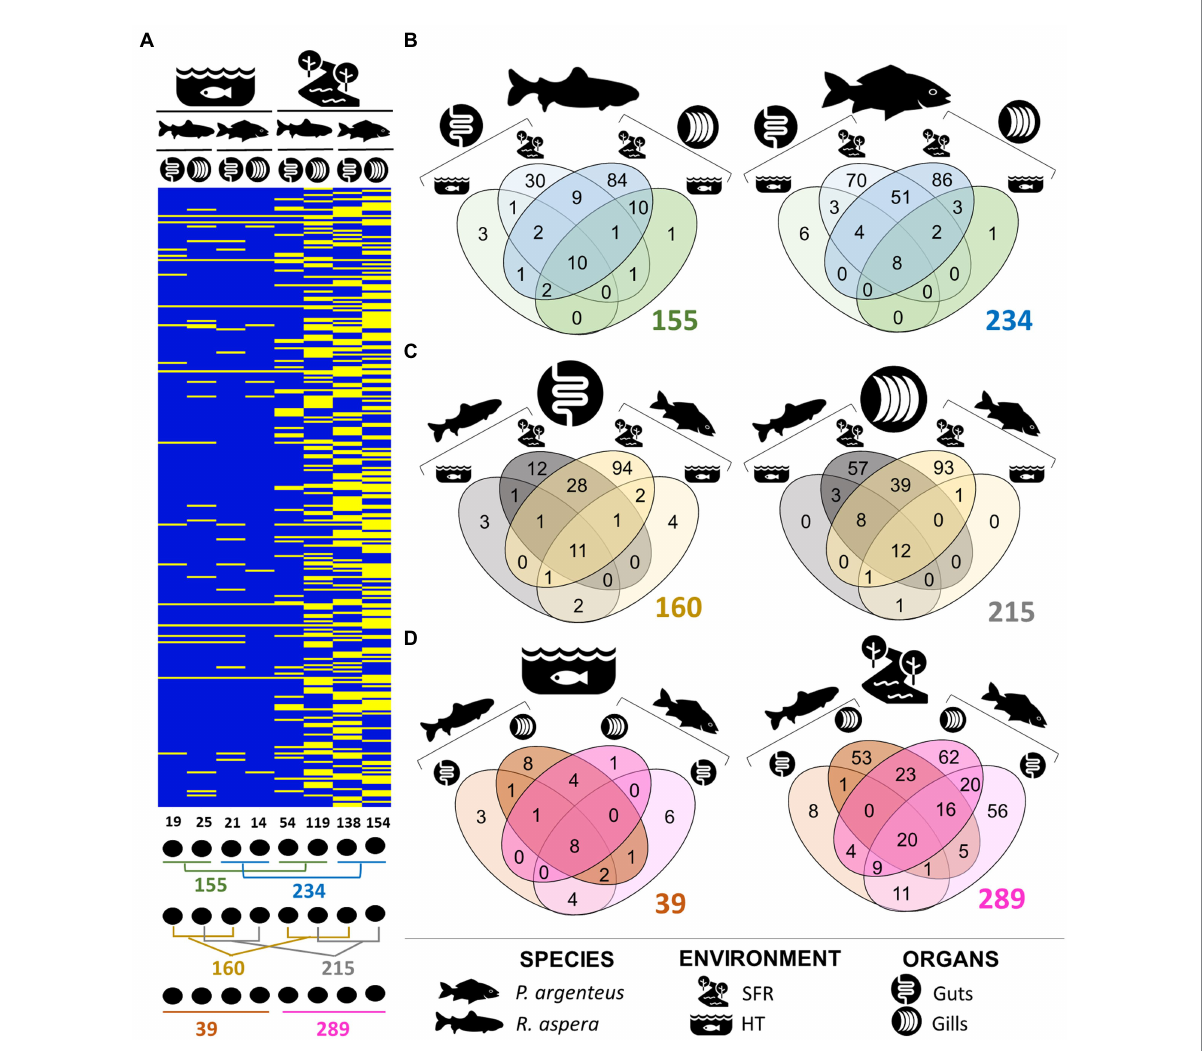
FIGURE 4 (A) Presence and absence of ASVs that attributed taxonomies at the genera level, illustrating the differences in the structure of the gill and intestinal microbiomes of R. aspera and P. argenteus collected in SFR and HT. Below the heatmap are shown the ways of comparison whose numbers are expressed in Venn diagrams (B–D) indicating the number of total, shared, and unique phylotypes in terms of genera level of the microorganisms associated with samples obtained from fish, according to the host species resident in different ecological systems (B) , different colonized body niches (C) and the host habitats (D)